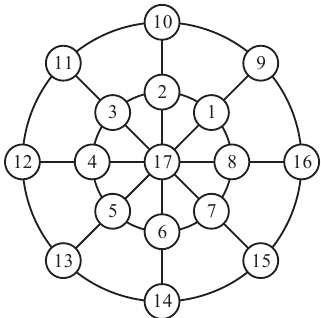
Figure 5. The admissible positions of the